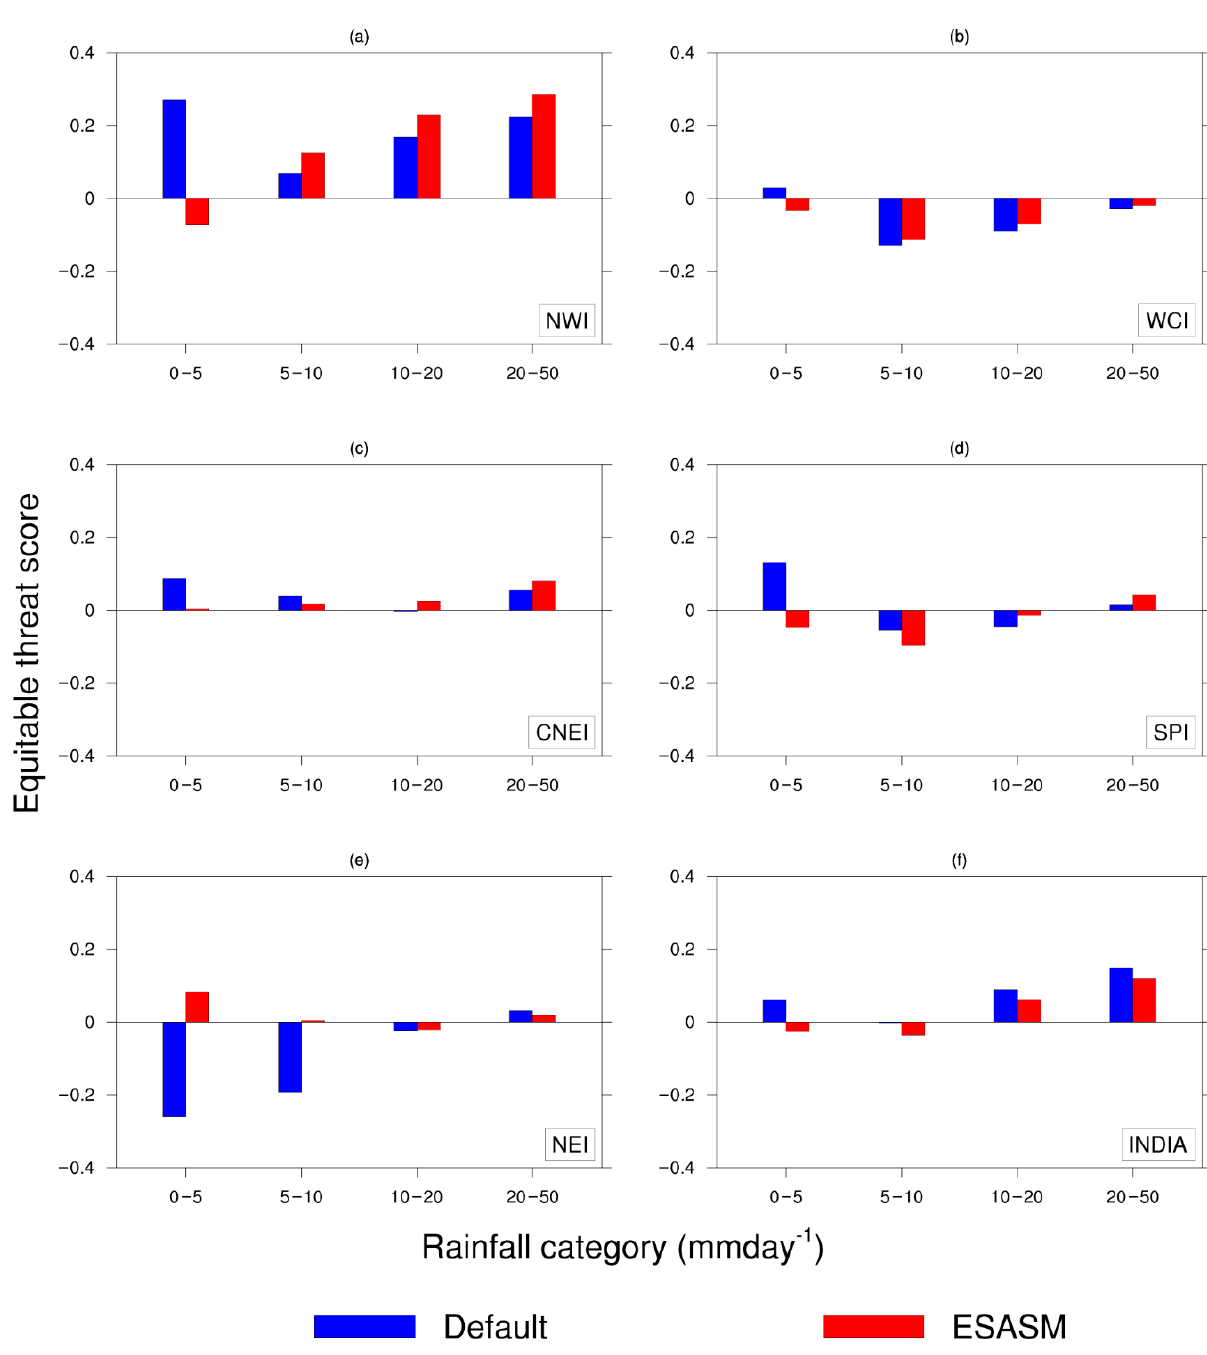
Figure 13. Equitable threat score for different rainfall categories (0–5, 5–10, 10–20 and 20–50 mmday − 1 )for the year 2002 over ( f ) the whole of India and ( a – e ) five homogeneous regions.